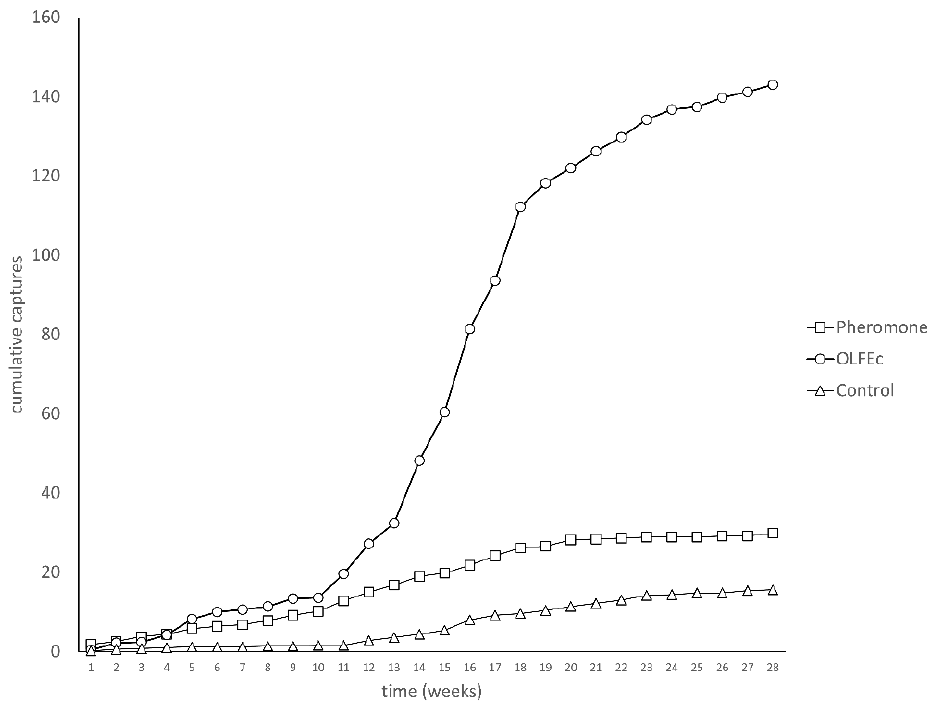
Figure 4. Capture of male CPB using a single lure of pheromone and OLFEc compared with un- baited traps over a period of 28 weeks. Five replicates per treatment were used in this experiment.